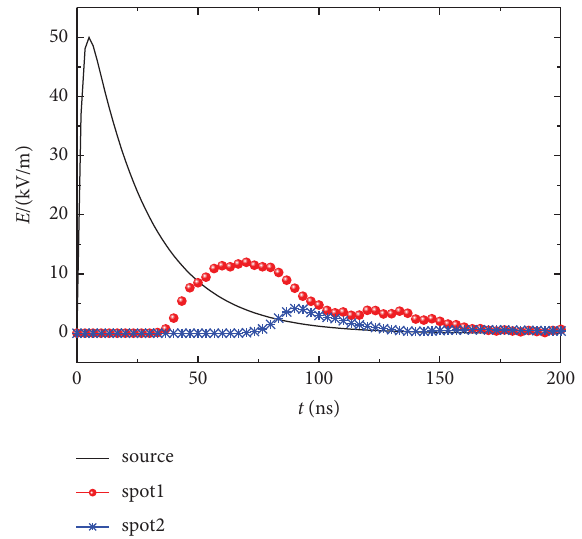
Figure 13: Time-domain waveform of the electric